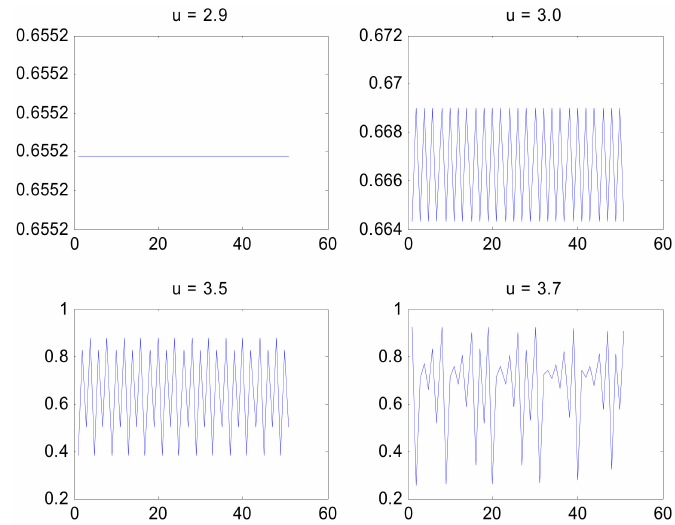
Figure 2. The behaviour of the logistic map with di ff erent values of the control parameter µ . The map has been iterated for 10000 times and the last 50 values of the time series are shown here.